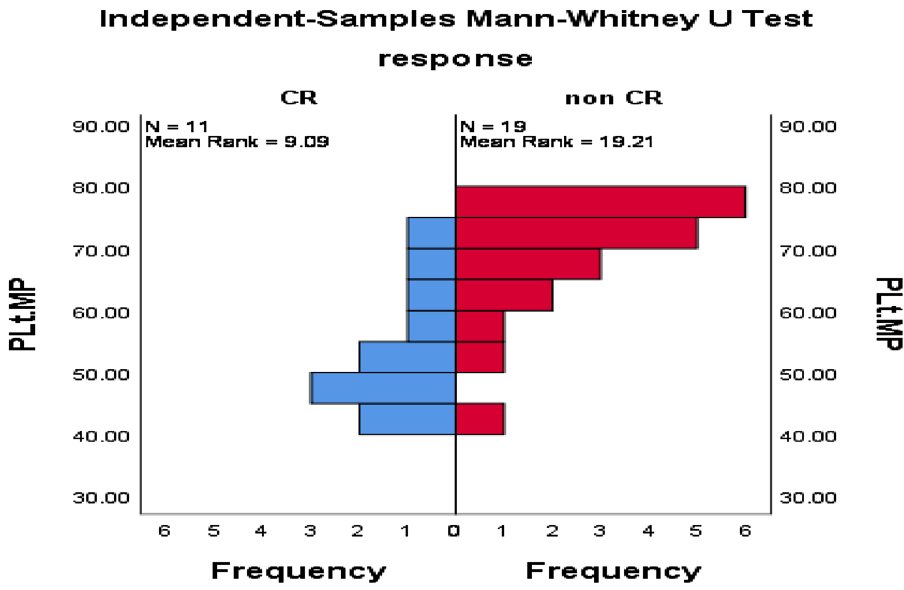
Figure 4. Significant difference in PMP among MM patients with CR versus those without CR, p = 0.002.